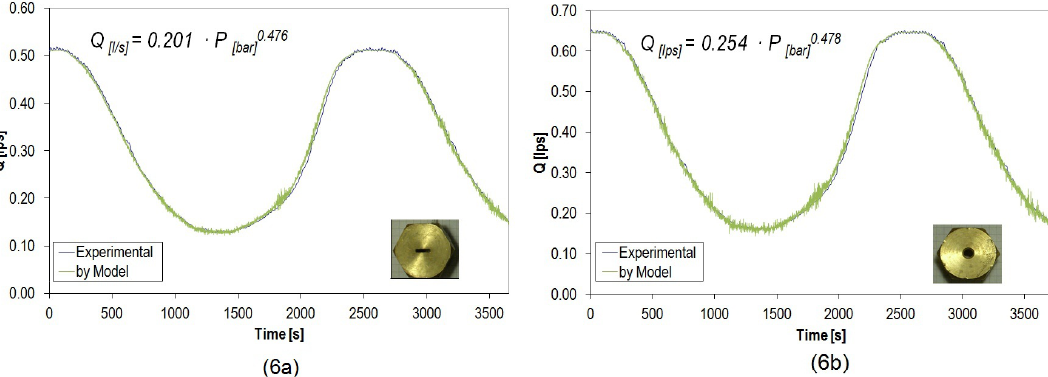
Figure 6. Comparison between time series for measured outflows and model results after calibration (rectangular nozzles, a – round noz- zle, b ).